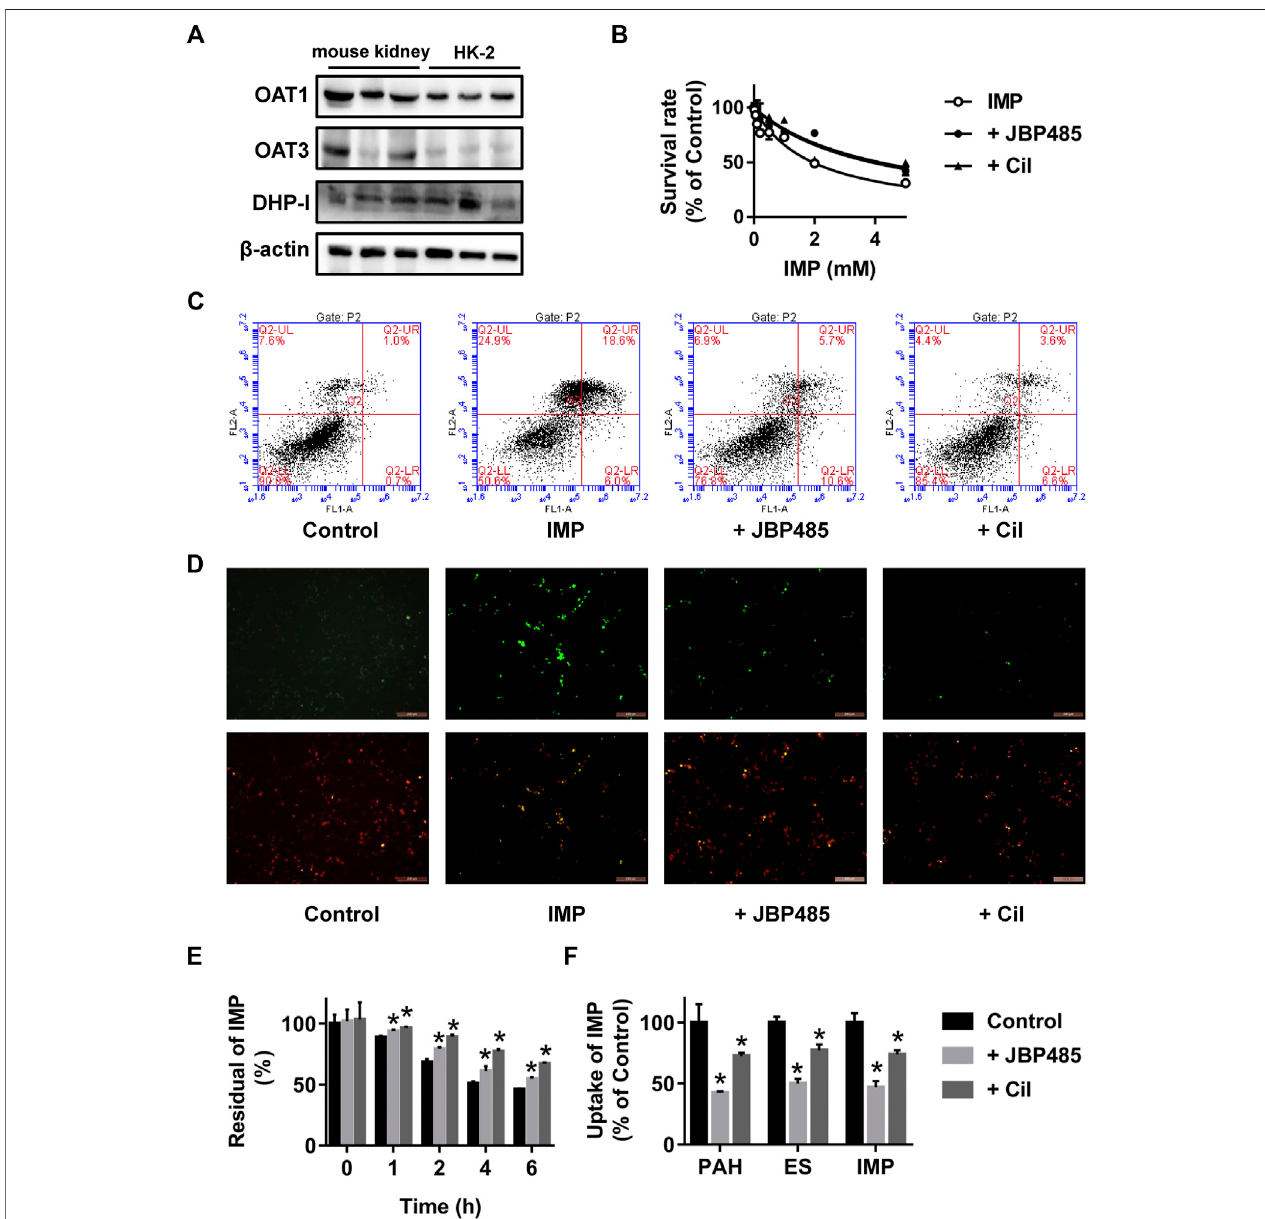
FIGURE2| EffectofJBP485andcilastatinonthecytotoxicity,stabilityandintracellularaccumulationofIMPinHK-2cells.ProteinexpressionlevelsofOAT1,OAT3 and DHP-IinHK-2cellsandthemousekidneybyWesternblotting (A) .HK-2cellswereincubatedwithIMP(0-5 mM)intheabsenceorpresenceofJBP485(500 μ M) or cilastatin (500 μ M) for 24 h and cell survival was determined by a CCK-8 assay (B) . HK-2 cells were incubated with IMP (2 mM) in the absence or presence of JBP485 (500 μ M) or cilastatin (500 μ M) for 24 h. Cell apoptosis and the mitochondrial membrane potential were evaluated by Annexin V/PI staining and JC-1 staining assays,respectively (C,D) .HK-2cellswereincubatedwithIMP(50 μ M)intheabsenceorpresenceofJBP485(50 μ M)orcilastatin(50 μ M).Theresidualconcentrationof IMP in the medium was determined by LC-MS/MS (E) . Intracellular accumulation of IMP in HK-2 cells was determined by LC-MS/MS after incubation with IMP (50 μ M) with or without JBP485 (50 μ M) or cilastatin (50 μ M) for 10 min (F) . Data are expressed as the mean ± SD.* p < 0.05 compared with control or IMP group ( n = 3).